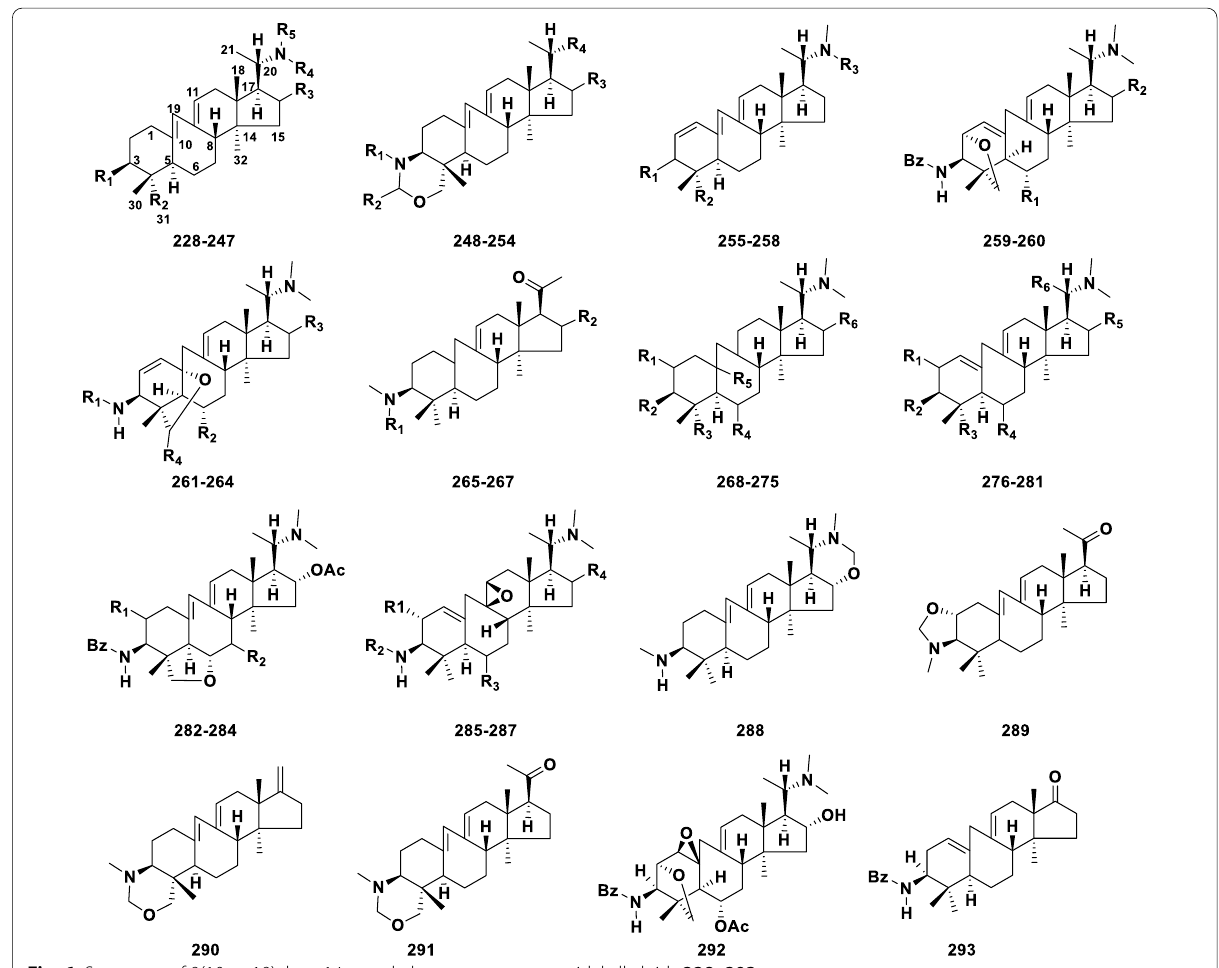
Fig. 6 Structures of 9(10 19)abeo‑14 α ‑methylpregnane type steroidal alkaloids →